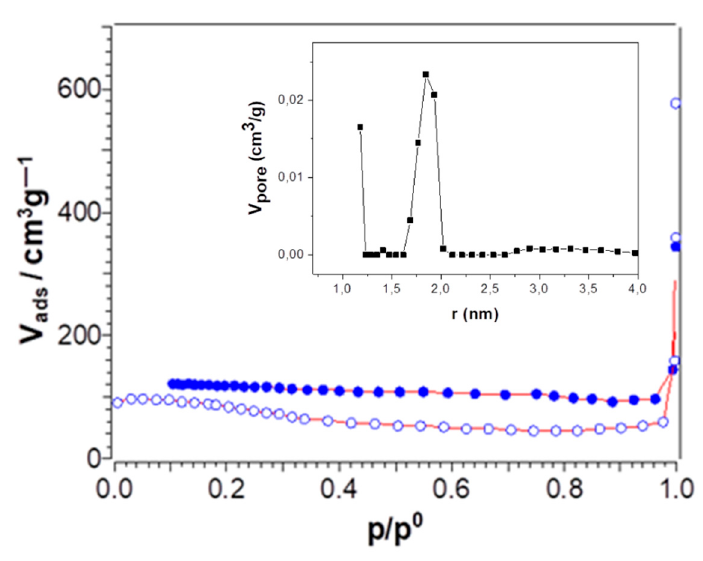
Figure 11. N 2 adsorption-desorption isotherms and pore size distribution (inset) for the coffee-derived carbon.